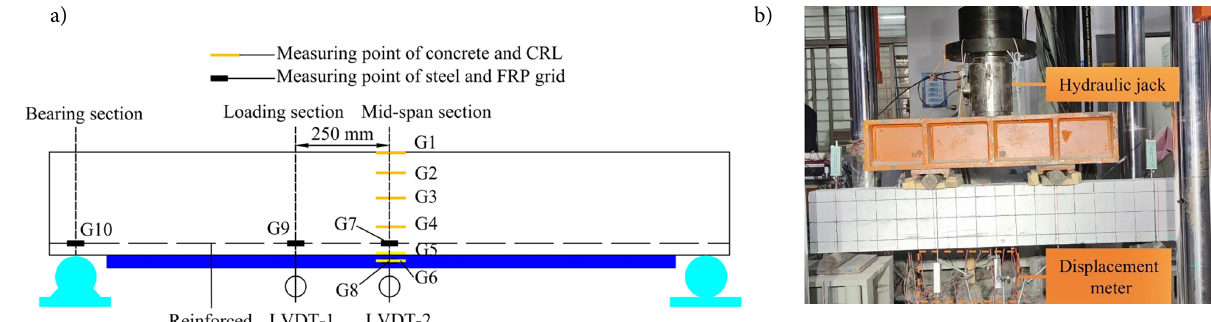
Figure 2. Experimental device: a – Distribution of the strain and displacement measurement points of the RC experimental beams; b – Loading scheme of the RC experimental